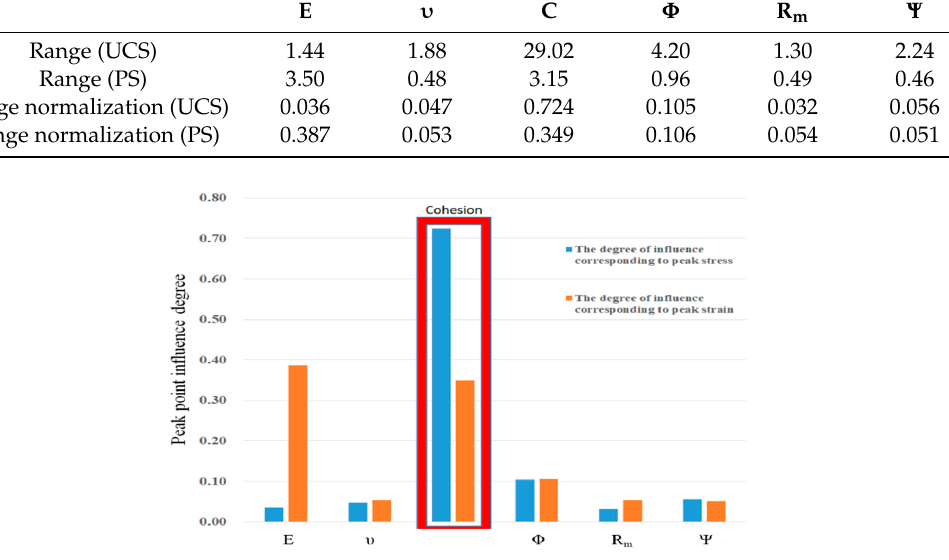
Table 7. Normalized range of each parameter corresponding to peak stress and peak strain.